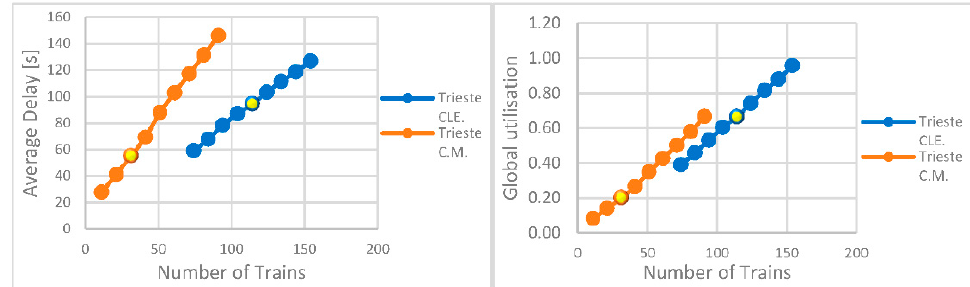
Figure 2. Average delay/train and global utilization rates were calculated for stations Trieste Centrale and Trieste Campo Marzio.